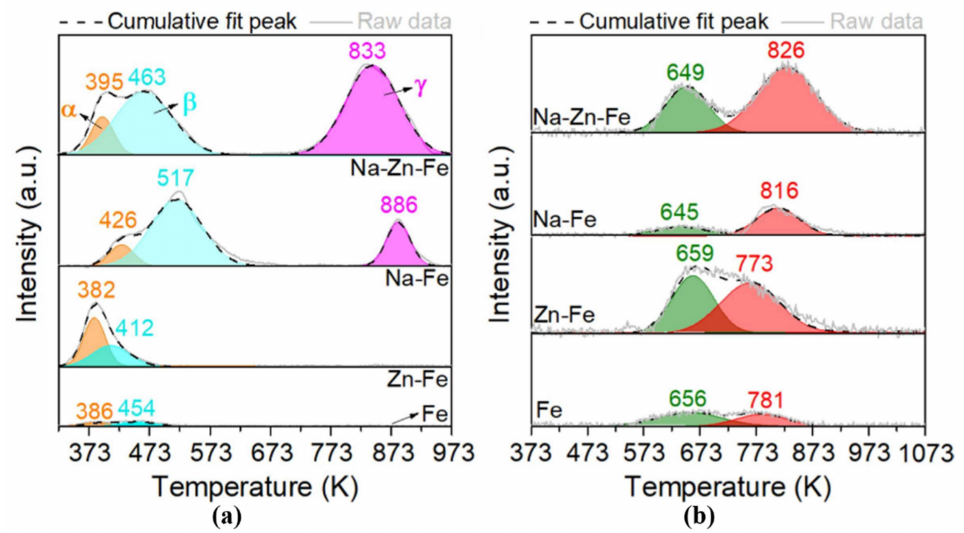
Figure 4. ( a ) CO 2 -TPD and ( b ) H 2 -TPD profiles of the reduced Fe-based catalysts. Reprinted with permission from Zhang et al. [40]. Copyright (2022)